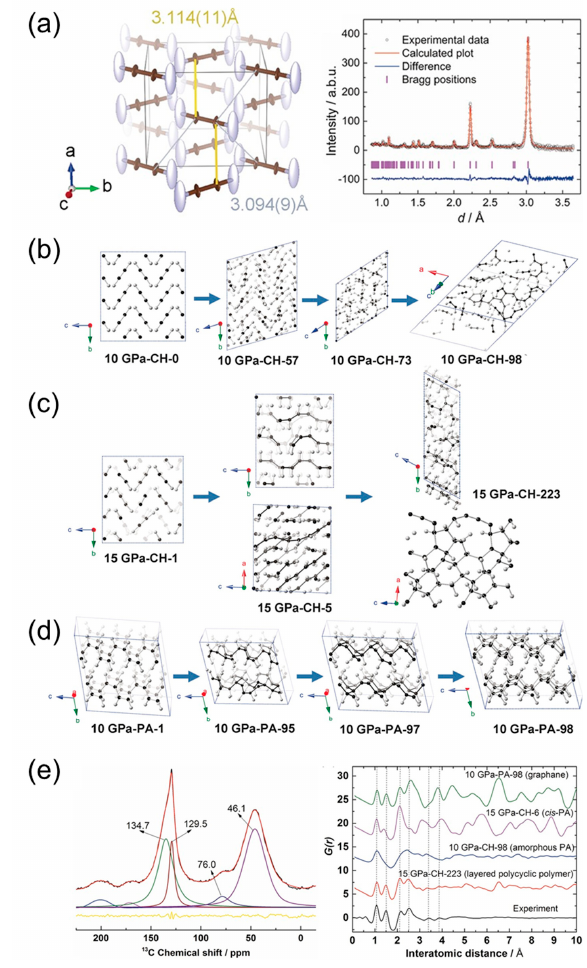
Commented [M3]: incorrect ref order, 95 detected after 89. Figure 7. ( a ) Crystal structure (left) and Rietveld refinement plot (right) of acetylene at 5.7 GPa, carbon and nitrogen are shown in brown and light blue ellipses, the shortest distance between the carbon atoms in adjacent molecules are indicated by yellow and brown lines [95]. Metadynamic simulation results of acetylene under ( b ) 10 GPa and ( c ) 15 GPa [95]. ( d ) Metadynamic simulation results of cis -polyacetylene under 10 GPa [95]. ( e ) The solid state nuclear magnetic resonance (left) and neutron PDF experiment data (right) of acetylene recovered from 10 GPa and the modeled PDFs G(r) of selected structural models of the metadynamic simulations shown in b, c, d [95].